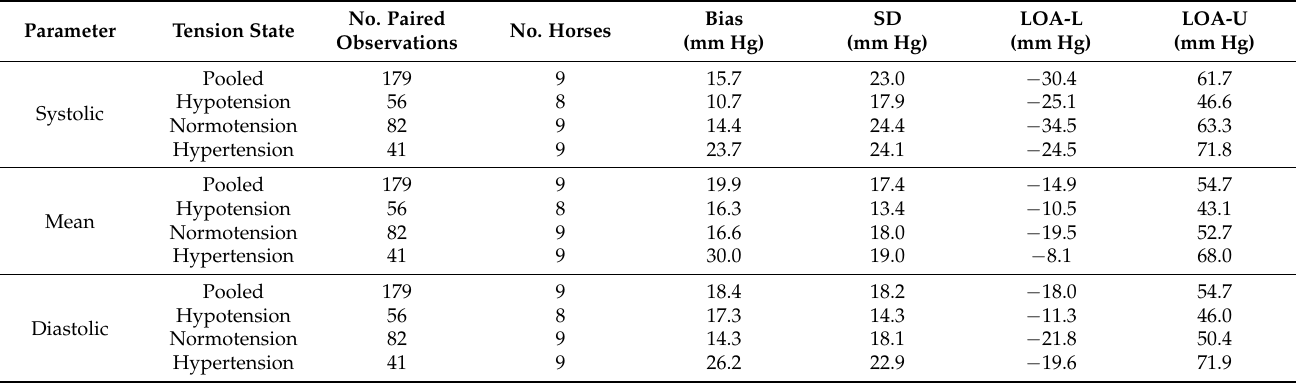
Table 3. Bland–Altmann analyses for 179 paired arterial blood pressure measurements made non- invasively compared to those made invasively using the Bionet BM7Vet in 9 healthy, standing